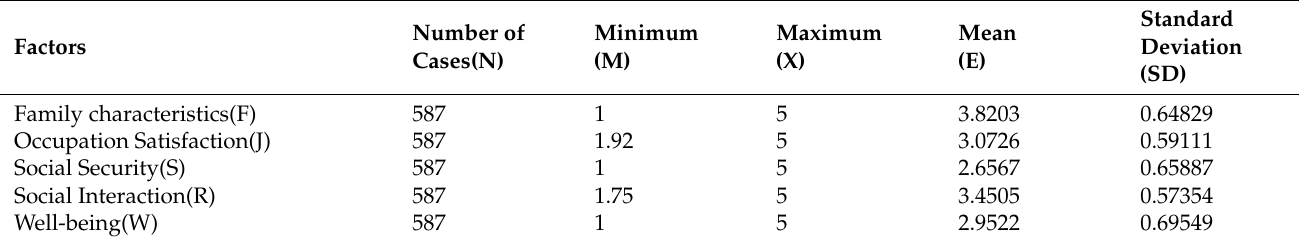
Table 4. Statistical Results of Migrant Gig Workers on Various Factors.